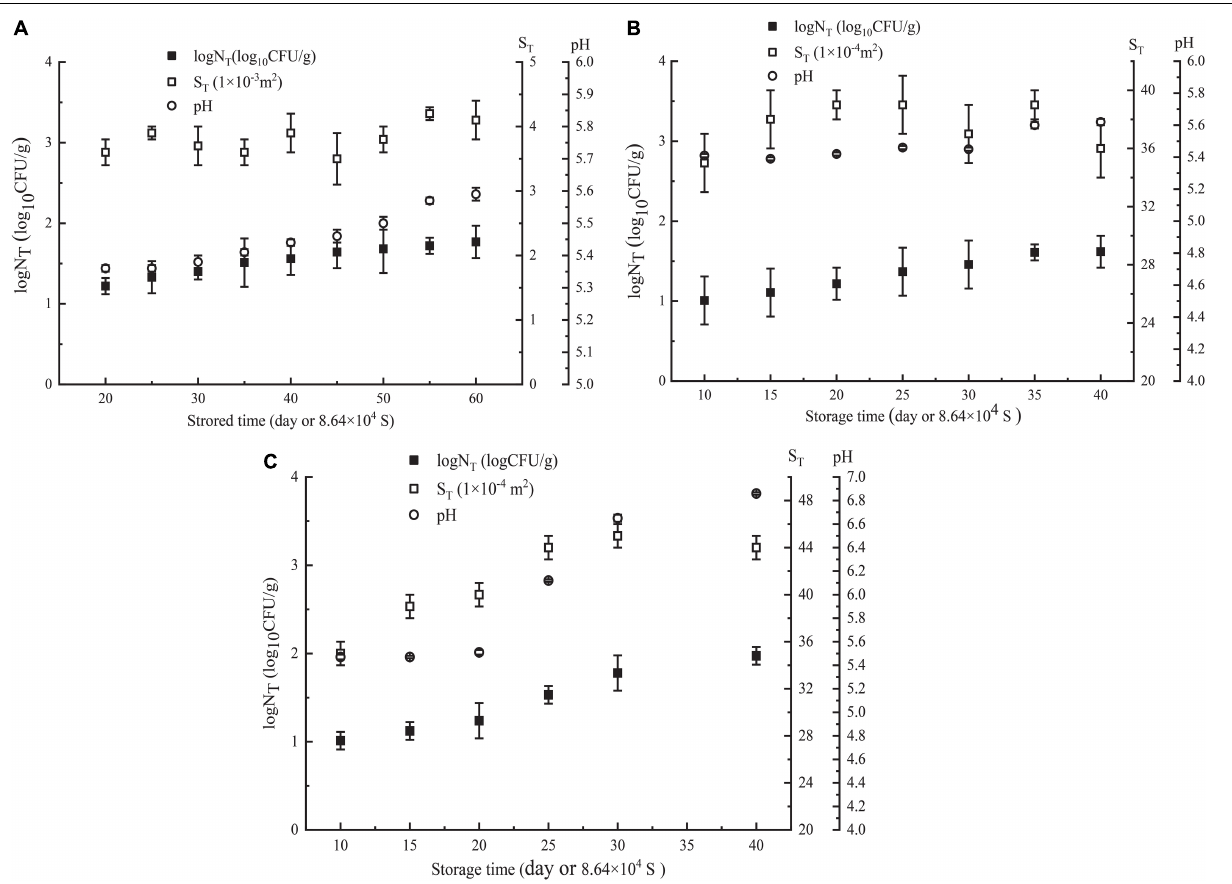
FIGURE 1 | Parameters of NGB (log N T , S T , storagetime, and pH values) obtained at different θ . (A) θ = 278 K, (B) θ = 283 K, and (C) θ = 288 K. N T means observed Pseudomonas number (CFU/g). Error bars represent the standard deviation of three independent samples.